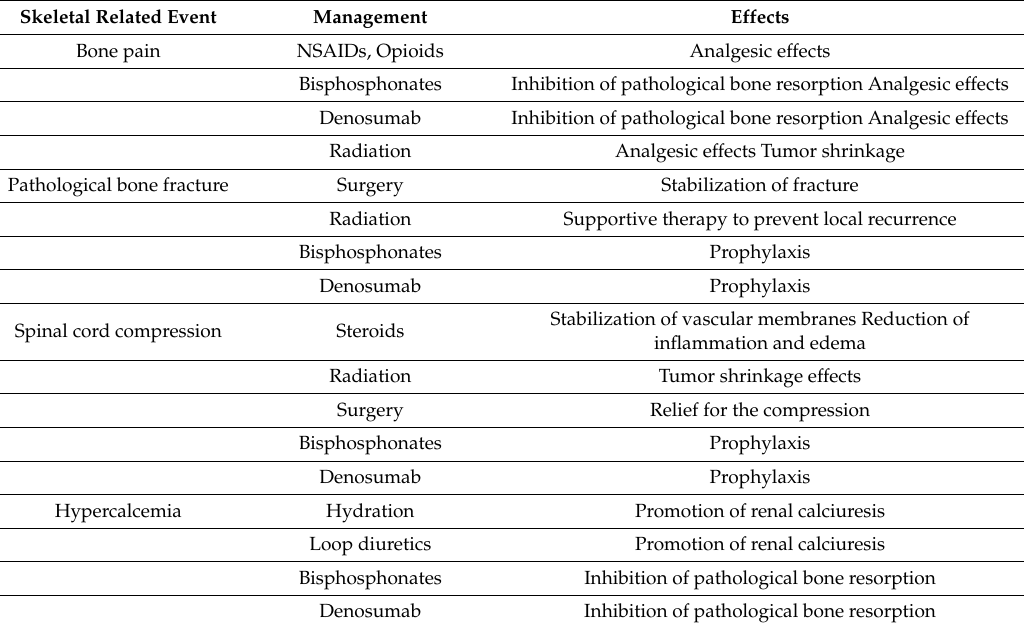
Table 1. Management of skeletal related